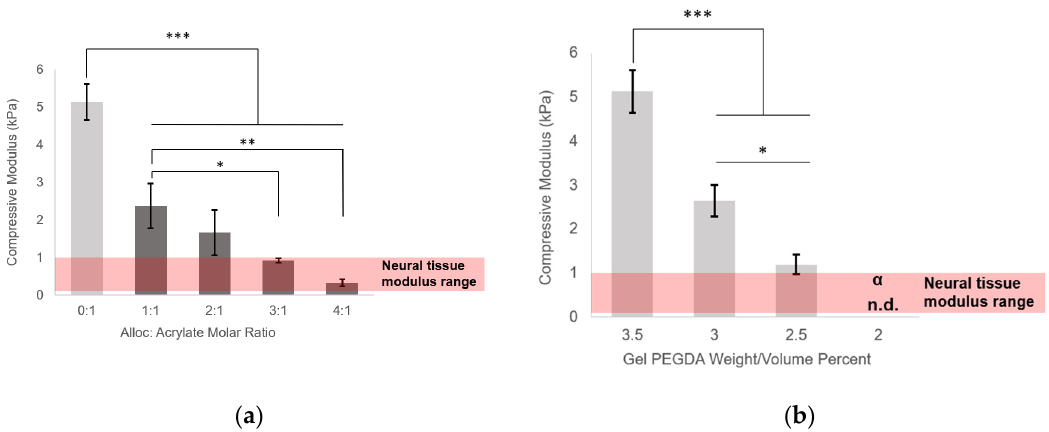
Figure 2. Hydrogel compressive moduli in response to H-Lys(alloc)-OH implementation and decreasing polymer density. Compressive modulus = slope of the stress–strain curve in the linear region following the toe region (Figure S1). Values reported as mean ± S.D. n = 4. * p < 0.05, ** p < 0.001, *** p < 0.0001, indicating a statistically significant difference. Statistical analysis evaluated by one-way ANOVA followed by Tukey–Kramer HSD tests. n.d. indicates no data, α : gels broke before evaluated strain region. ( a ) gel modulus reduced by increasing H-Lys(alloc)-OH concentration, neuronal stiffness achieved at highest monomer concentrations; ( b ) reducing polymer density decreases compressive modulus but does not reach neural tissue compliance.